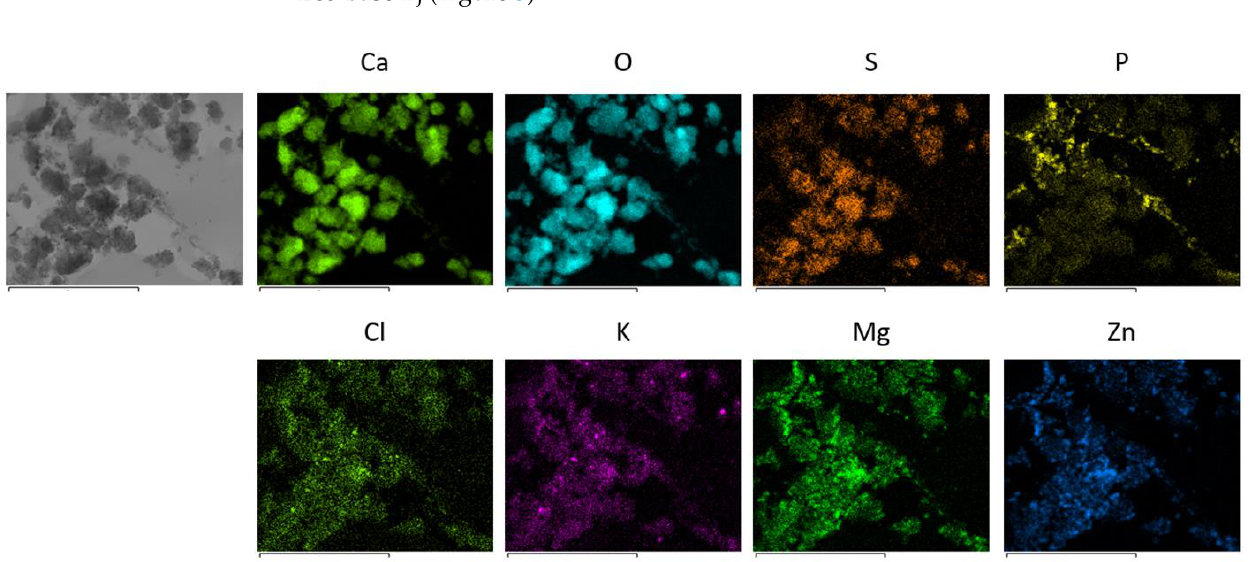
Figure 2. HR-TEM mapping of Eco-base-Ah (scale bar: 1 µm) .